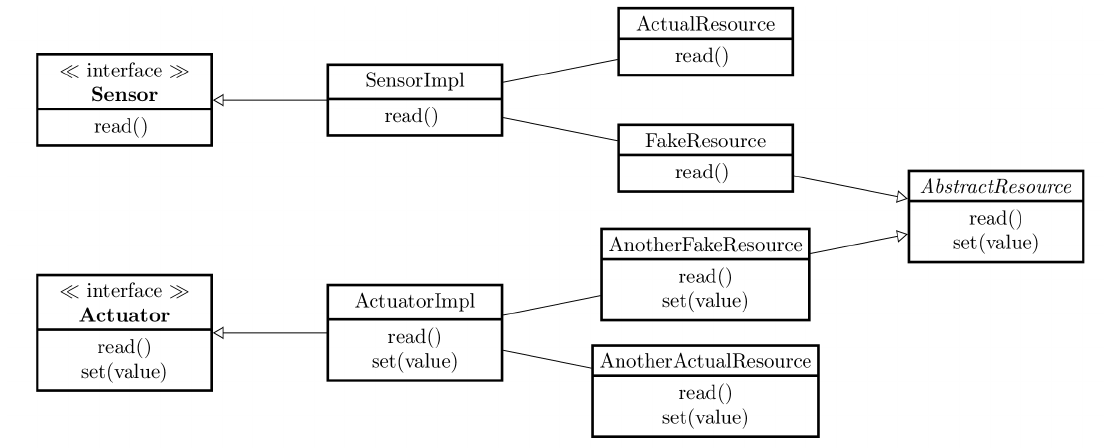
Figure 5. Resources, Sensors, and Actuators structure